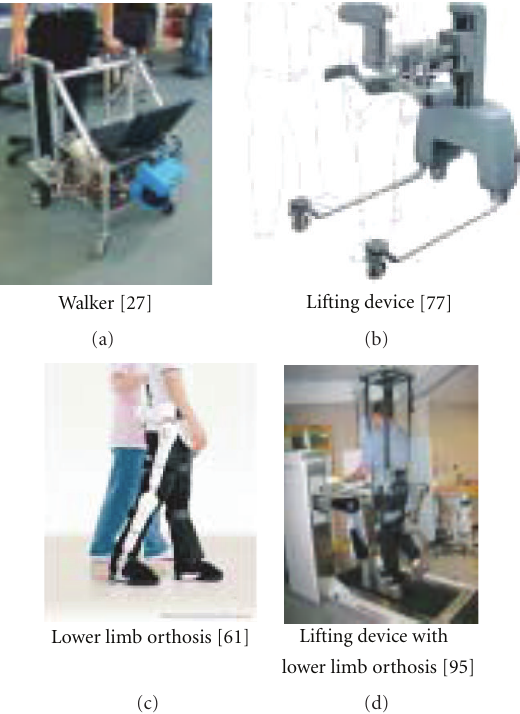
Figure 2: Type of gait